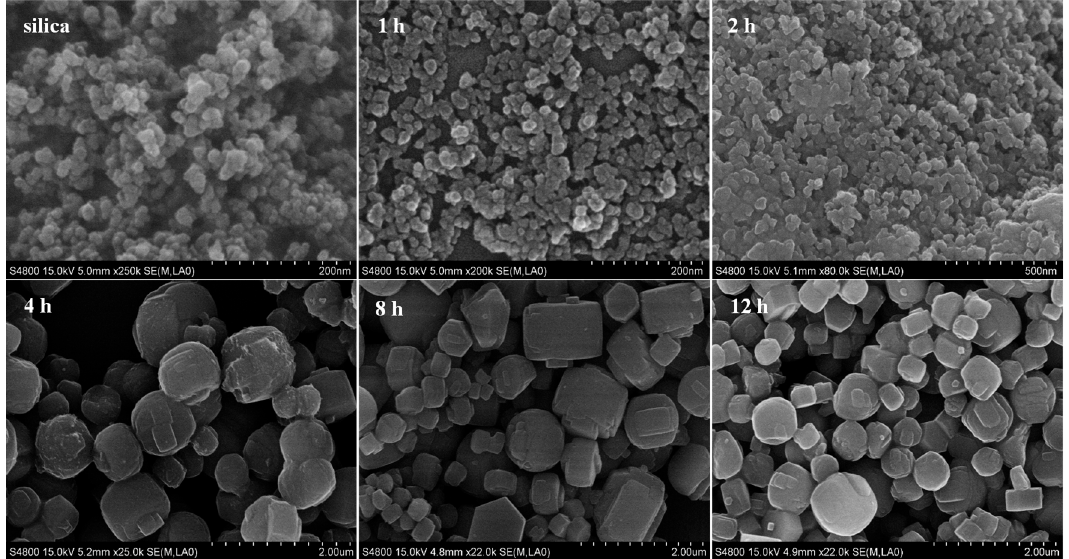
Figure 2. The SEM images of silicalite-1 synthesized from silica with particle size of 12 nm.